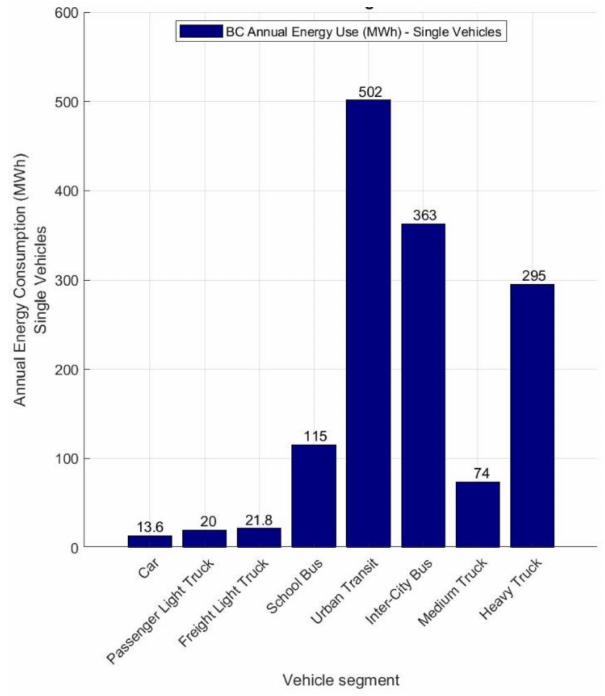
Figure 6. B.C. road transportation annual energy use for single vehicles in (MWh), B.C. statistical data from